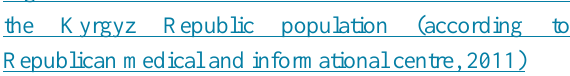
and 18.1 % in age categories 30-39 and 40-59, respectively. Figure 5: Death rate from cardiovascular diseases in Kyrgyzstan, ages 30-39.